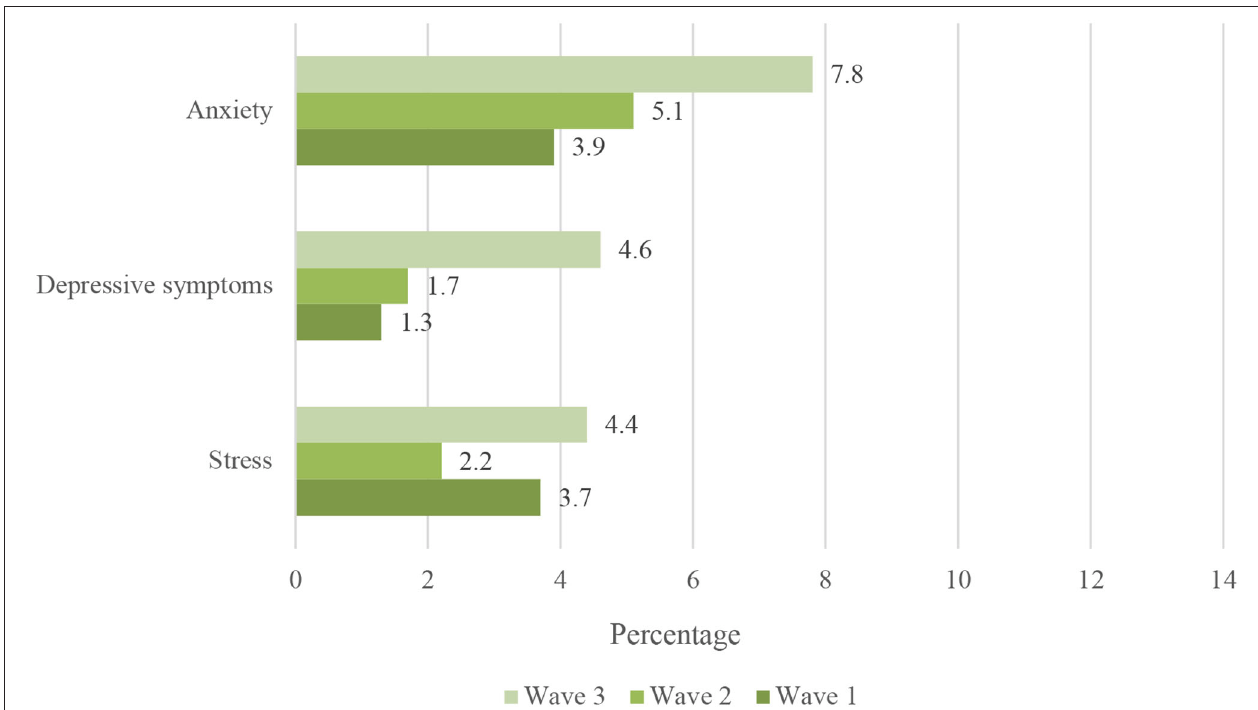
FIGURE 2 | Comparison of the proportion of older adults with detection of anxiety, depression and stress in the three waves.